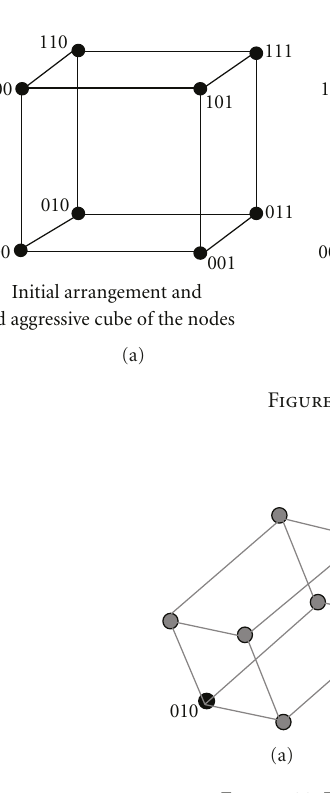
Figure 11: FCC algorithm: addressing of the new